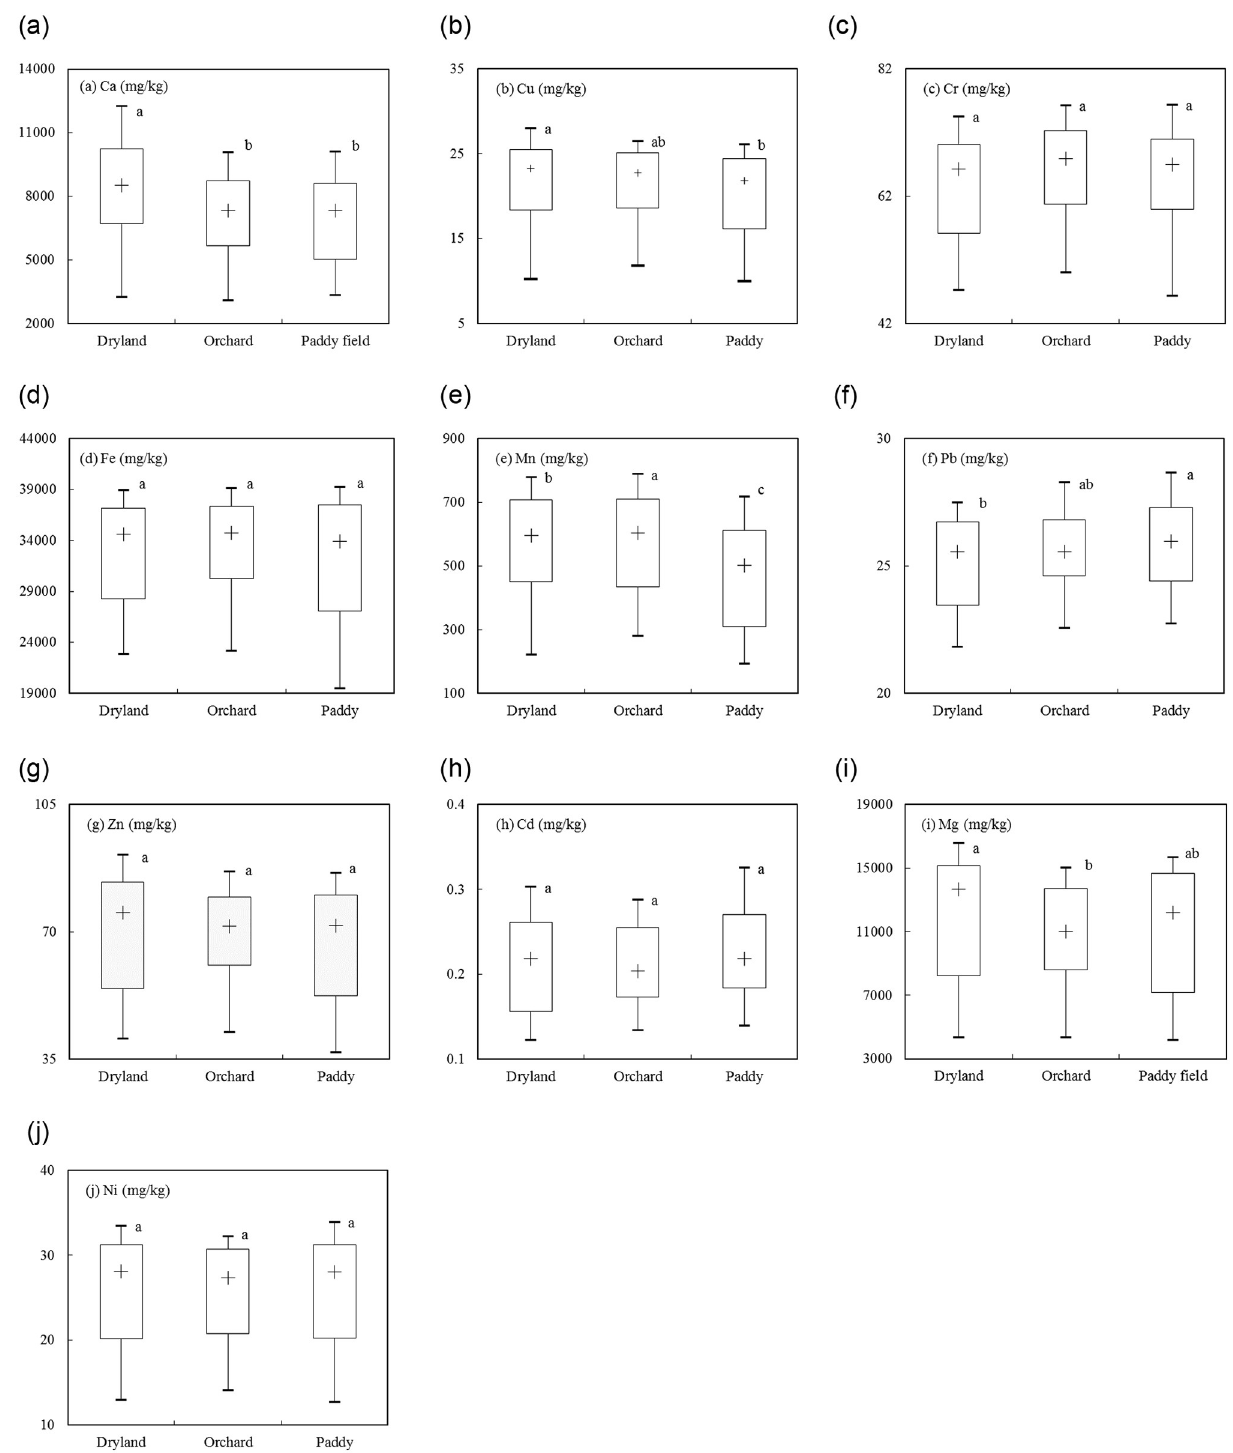
Fig 2. Box plots (in 10-25-50-75-90th percentiles) of metal elements under dryland, orchard and paddy land use (different letters within each plot indicate significant difference in metal element between the land use type at p < 0.05).